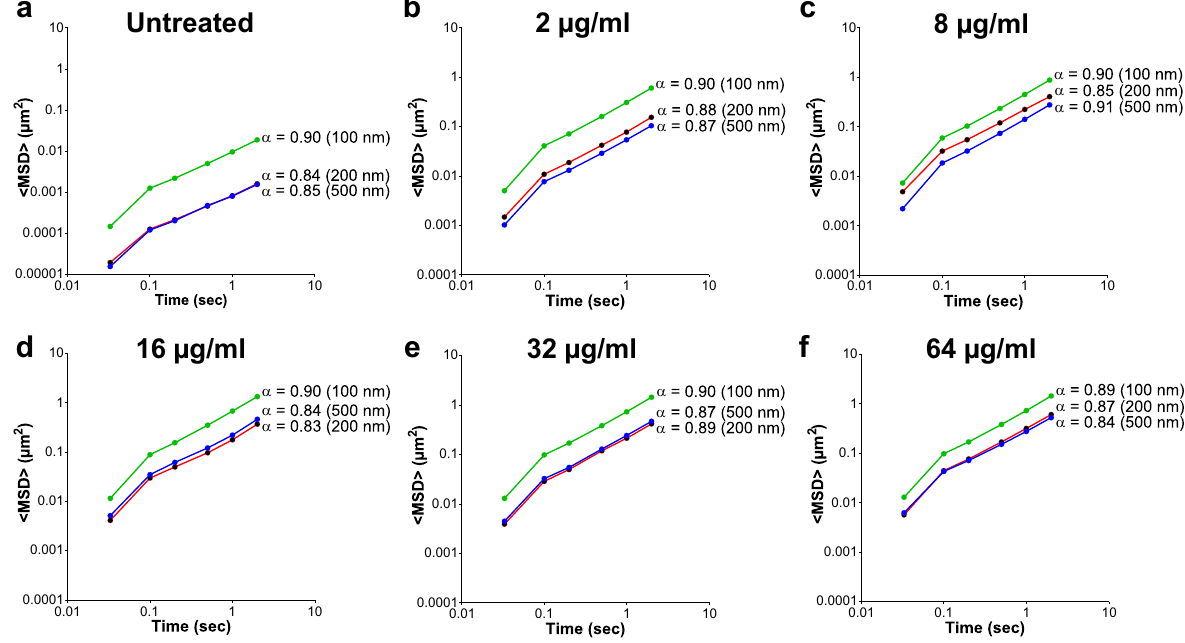
Fig. 4 Exponential anomalous values < α > of E. coli IR57 (PMB Sens ) bio fi lms treated with Polymyxin B. Exponential anomalous values < α > of E. coli IR57 bio fi lms in response to polymyxin B treatment using 100, 200 and 500 nm negatively charged carboxylate-modi fi ed Fluo Spheres ® a untreated control; b 2; c , 8; d , 16; e , 32; and f 64 µg/ml polymyxin B treatment. α is measured based on the relation between the ensemble mean square displacement (MSD) versus time scale of the traced Fluo Sphere ® particles and re fl ects the micro-rheological degree of resistance of the bio fi lm towards traced particles where; α > 0.5 indicates viscous resistance; α < 0.5 indicates elastic resistance. <MSD> represents the geometric mean of MSDs of 360 particles ( n = 3, each 120 polymyxin B treatment, were all signi fi cantly different from the control ( P < 0.05). Polymyxin B treatment (2 – 8 µg/ml) revealed a greater increase effective diffusion coef fi cients (<Deff>) within the treated bio fi lms for all three NP sizes tested (100, 200 and 500 nm; Fig. 3), with the 100 nm NPs revealing the greatest dose-dependent sensitivity in diffusion coef fi cients to antibiotic treatment. The dose-dependent changes in NP diffusion coef fi cients, starting from 2 µg/ml